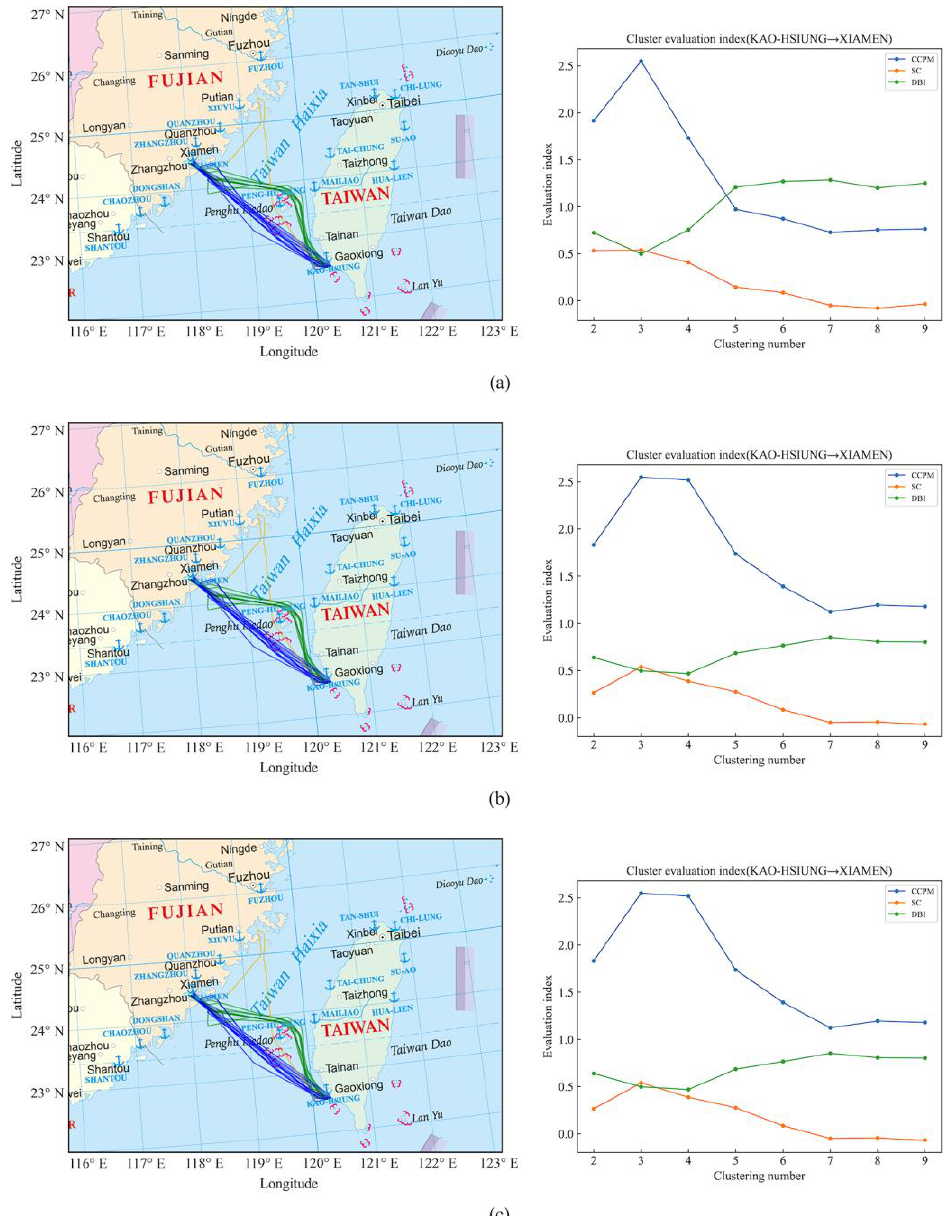
Figure 16. ( a ) K-Means clustering results and quantitative evaluation results of the ship trajectories from Kaohsiung Port to Xiamen Port. ( b ) DBSCAN clustering results and quantitative evaluation results of the ship trajectories from Kaohsiung Port to Xiamen Port. ( c ) BIRCH clustering results and quantitative evaluation results of the ship trajectories from Kaohsiung Port to Xiamen Port.